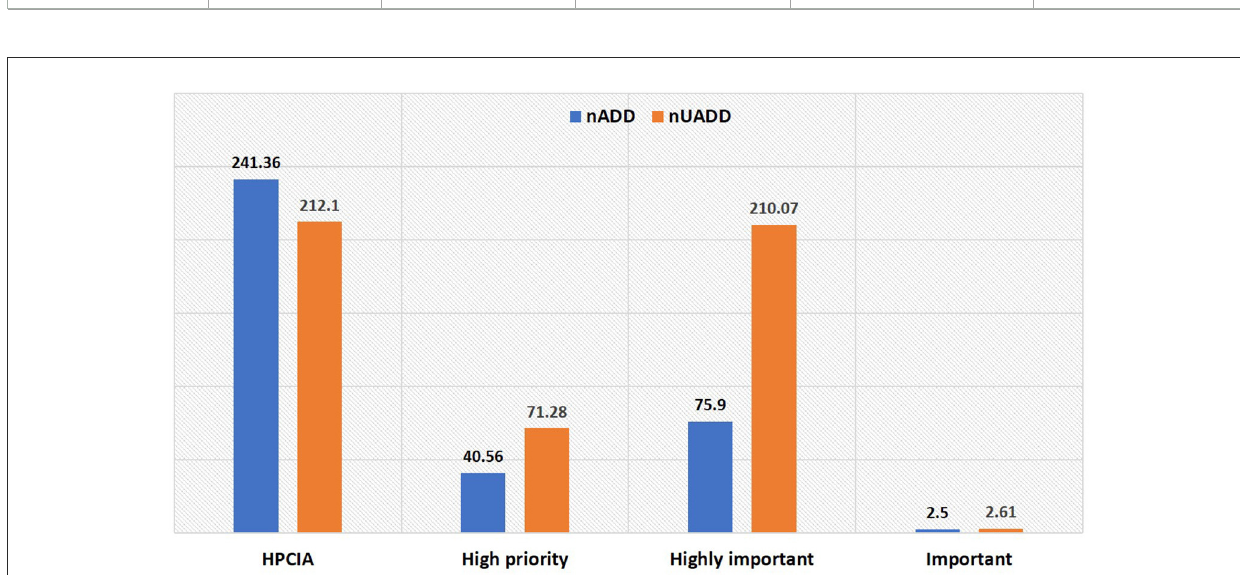
FIGURE1 World Health Organization (WHO) Critically Important Antimicrobials (CIA) categorization of antimicrobials used in the herd in terms of number of used animal daily dose (nUADD) and number of animal daily dose